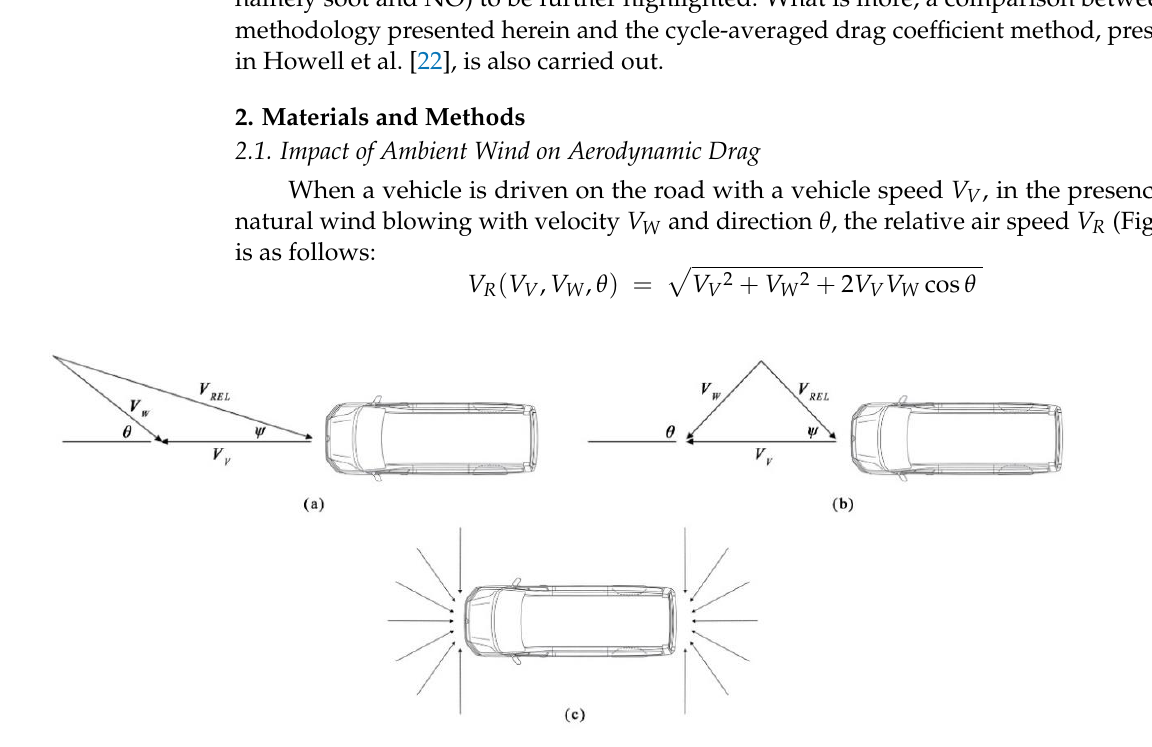
Figure 1. ( a ) Velocity triangle for headwind, ( b ) Velocity triangle for tailwind, ( c ) Headwinds and tailwinds approaching the vehicle equiprobably.